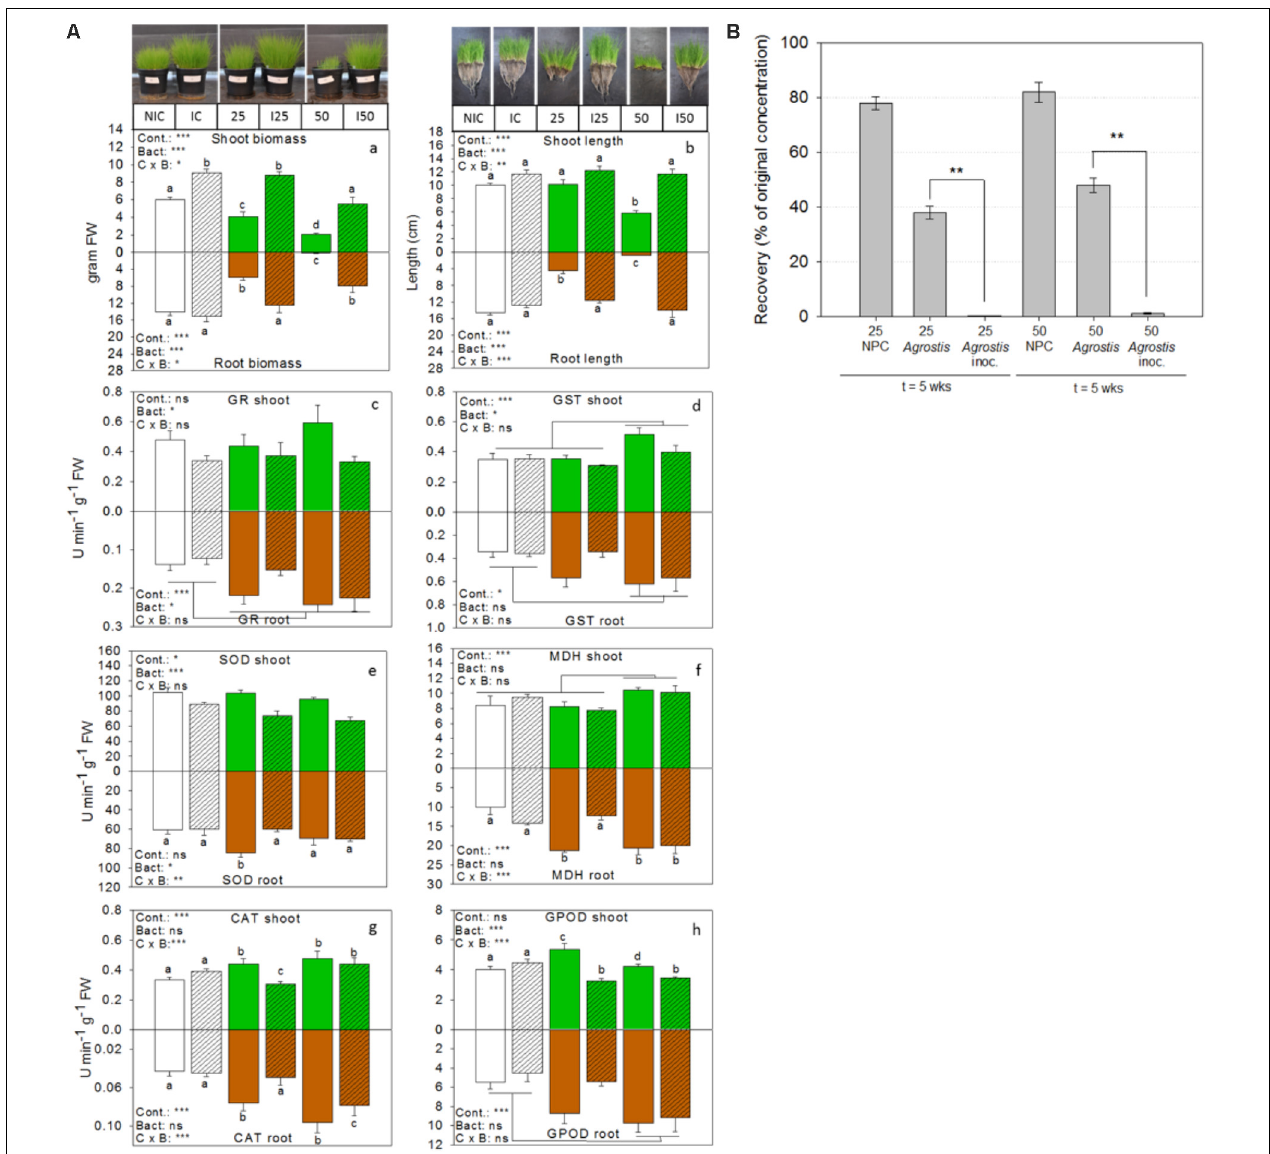
FIGURE 5 | Bioaugmentation with consortium ST1 in the rhizosphere of common bent grass increases biomass, removes TNT and increases plant health. (A) Bar graphs showing plant biomass, shoot and root length, and activities of enzymes related to antioxidative defense for inoculated (I) TNT-exposed plants, inoculated non-exposed plants (IC) and non-inoculated non-exposed control plants (NIC). Shoot responses are shown in green (white for the control) and belowground root responses are shown in brown (white for the control). Bacteria inoculation conditions are shown in hatched bars. Enzyme activities are expressed in units per min and gram fresh weight. TNT exposure concentrations were 25 and 50 mg TNT per kg dry weight sand. Values represent average and standard-error of 8 biological replicates per treatment, ∗ p < 0.05; ∗∗ p < 0.01; ∗∗∗ p < 0.001; ns, not significant. Cont., control; Bact., bacteria; C × B, contamination x bacteria interaction effect (two-way ANOVA, Holm–Sidak, n = 8). (B) Percentage of TNT remaining in the substrate after 5 weeks of growth. GR, glutathione reductase; GST, glutathione transferase; SOD, superoxide dismutase; MDH, malate dehydrogenase; CAT, catalase, GPOD, guaiacol